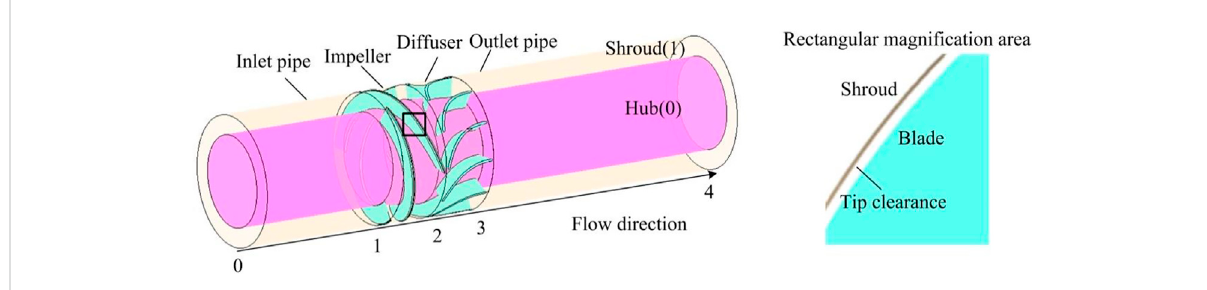
FIGURE 1 Simpli fi ed model of the computational domain.